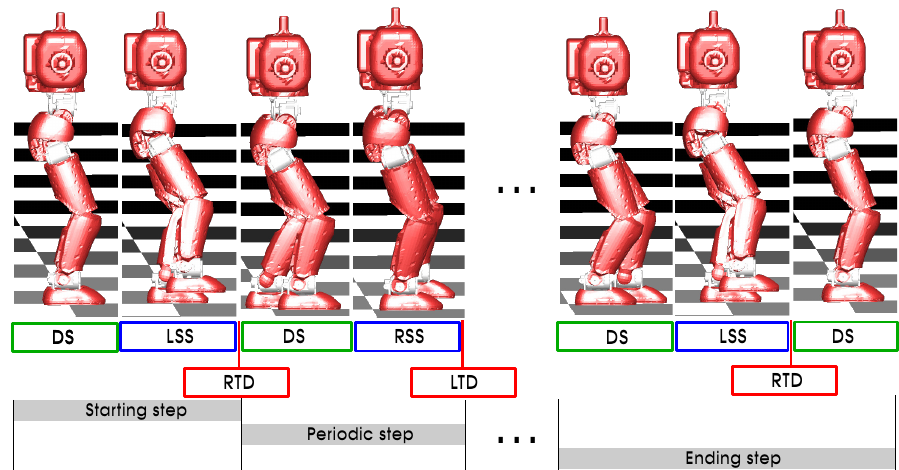
Figure 2. Walking phases of HeiCub. DS = Double Support, LSS = Left Single Support, RSS = Right Single Support, LTD = Left Touch Down, RTD = Right Touch Down. The whole sequence can be seen as three sub-sequences. The periodic step can be repeated for a desired number of times that do not need to be further